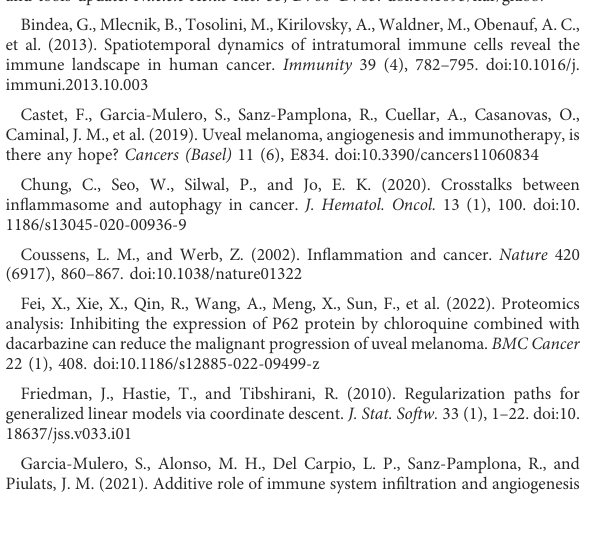
SUPPLEMENTARY FIGURE S1 Analysis of mitophagy-related genes expression among different subgroups. Group comparison diagram showing the results of differential expression analysis of mitophagy-related genes in different groupsofTCGA-UMdataset,including (A) ATG5 . (B) ATG12 . (C) CSNK2A1 . (D) CSNK2B . (E) FUNDC1 . (F) MAP1LC3A . (G) MAP1LC3B . (H) MFN1 . (I) MTERF3 . (J) PGAM5 . (K) PRKN . (L) RPS27A . (M) TOMM5 . (N) TOMM20 . (O) TOMM70 . (P) UBA52 . Ns, not signi fi cant; * p < 0.05; ** p < 0.01; *** p < 0.001. TCGA, the cancer genome atlas; UM, uveal melanoma. SUPPLEMENTARY FIGURE S2 Correlationanalysisbetweenimmunecellsandmitophagy-relatedgenes scores. The scatter plot of the correlation analysis results between mitophagy-related genes score and the in fi ltration abundance of immune cell including CD56dim.natural.killer.cells (A) , Eosinophils (B) , Gamma delta T cells (C) , Mature B cells (D) , Macrophages (E) , Mast cells (F) , MDSCs (G) , Monocytes (H) , Neutrophils (I) and Type 2 T helper cells (J) . The slope is the magnitude of the correlation, and the p-value indicates the level of signi fi cance. P ≥ 0.05, not statistically signi fi cant; P < 0.05, statistically signi fi cant; P < 0.01, highly statistically signi fi cant; P < 0.001, extremely statistically signi fi cant. The absolute value of the correlation coef fi cient (R) in the correlation scatter plot is above 0.8, whichisastrongcorrelation; Theabsolutevaluebetween0.5and0.8is a moderate degree of correlation; The absolute value between 0.3 and 0.5 is weakly correlated; The absolute value below 0.3 is considered weak or